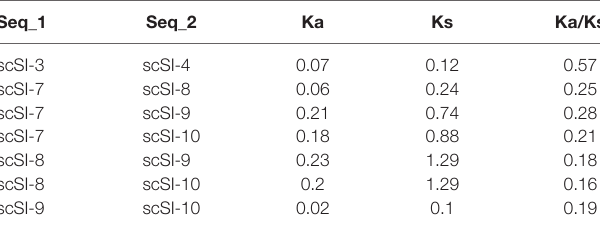
TABLE 3 | Ka/Ks of duplicated genes.